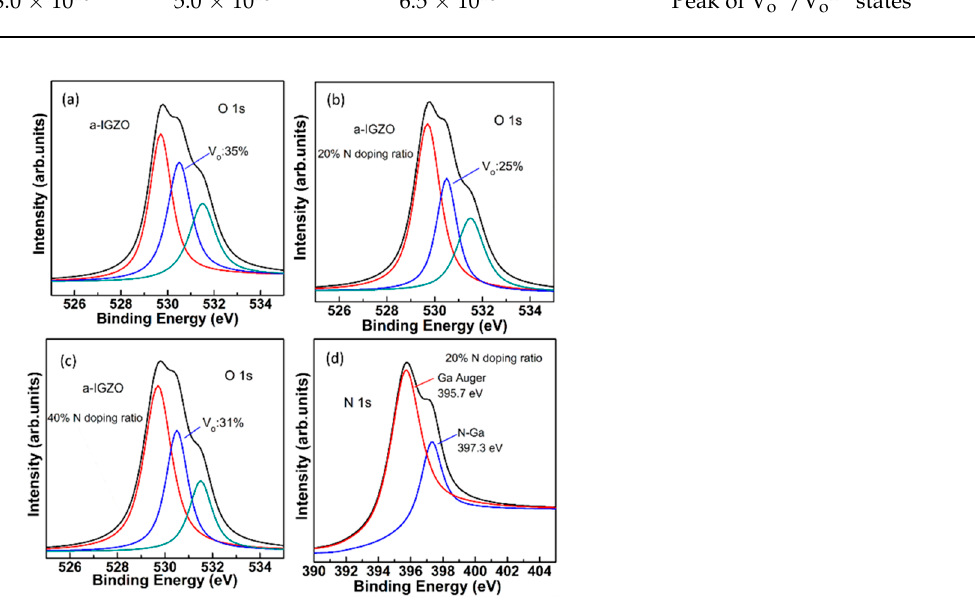
Figure 3. O 1s XPS spectra of the annealed a-IGZO films grown using N-doping ratio of ( a ) undoped, ( b ) 20% and ( c ) 40%. ( d ) N 1s XPS spectra of a-IGZO film grown with 20% N-doping